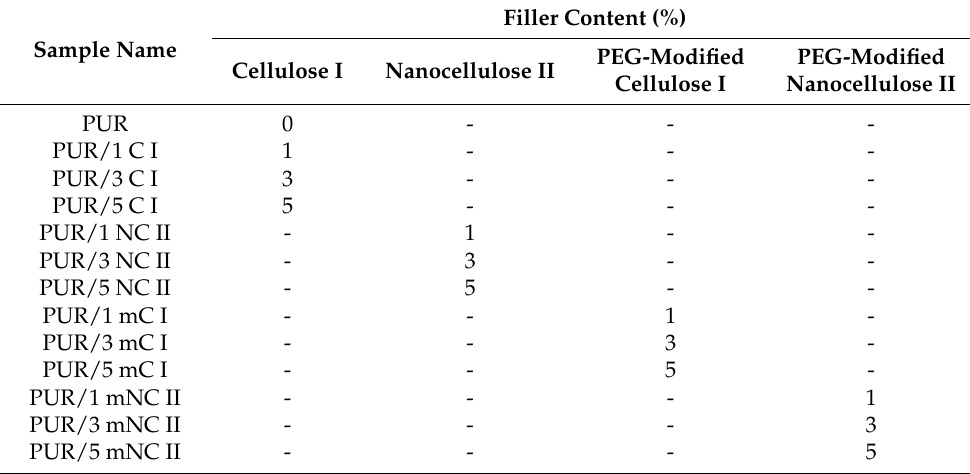
Table 1. Compositions of the samples.